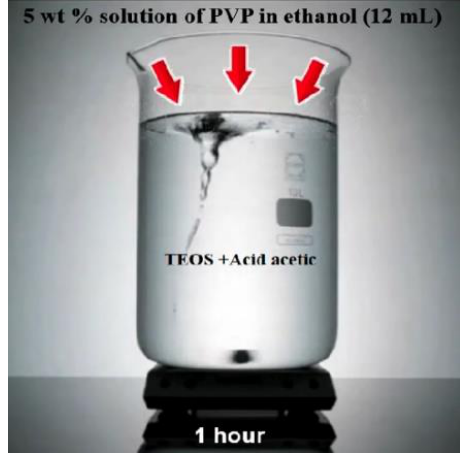
Figure 4. Adding 5 wt% solution of PVP.